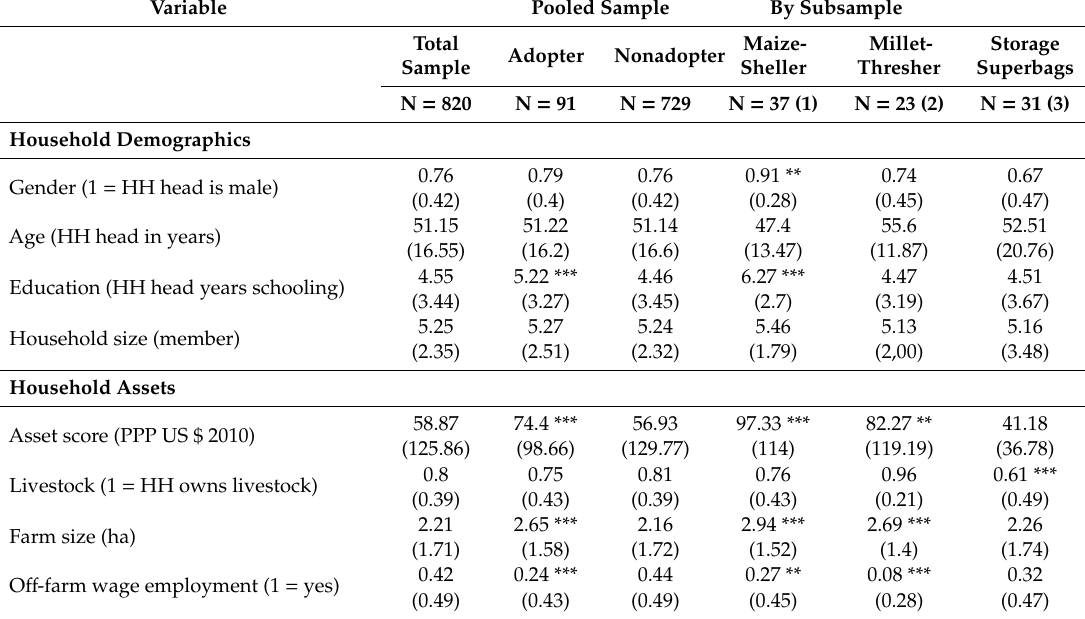
Table A3. Summary statistics of rural farmer’s adoption scheme in